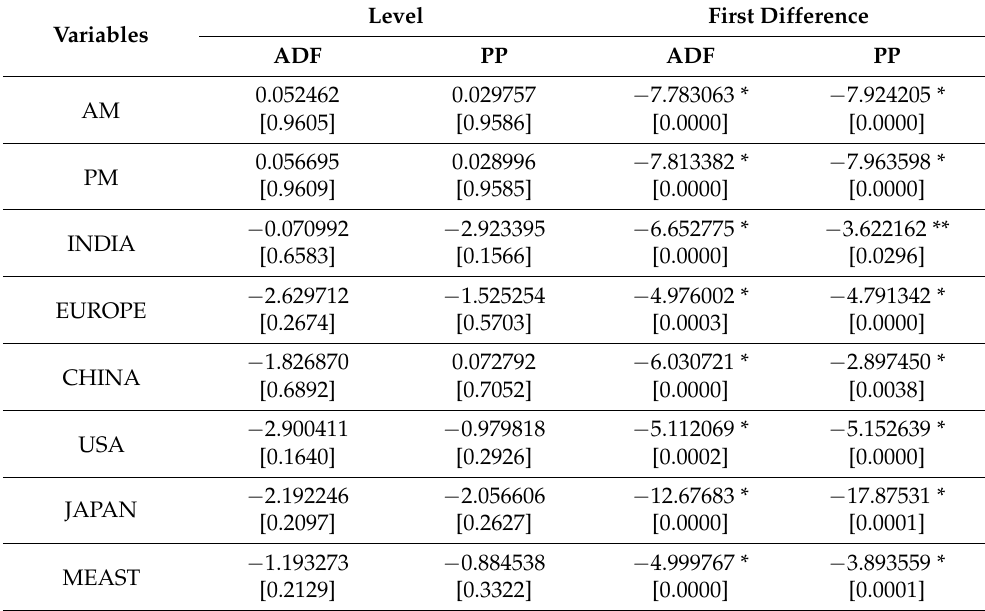
Table 2. Stationarity of variables during different study